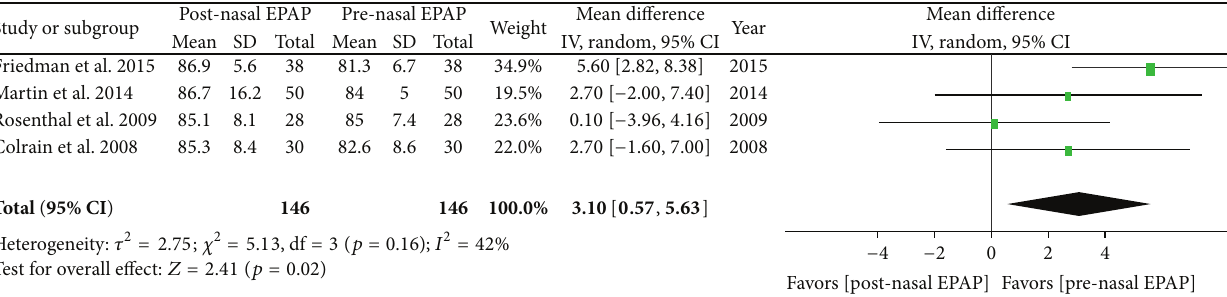
Figure 5: Pre- and post-nasal EPAP therapy outcomes for lowest oxygen saturation (percent), mean difference. SD: standard deviation; CI: confidence interval; nasal EPAP device: nasal expiratory positive airway pressure device (Provent).